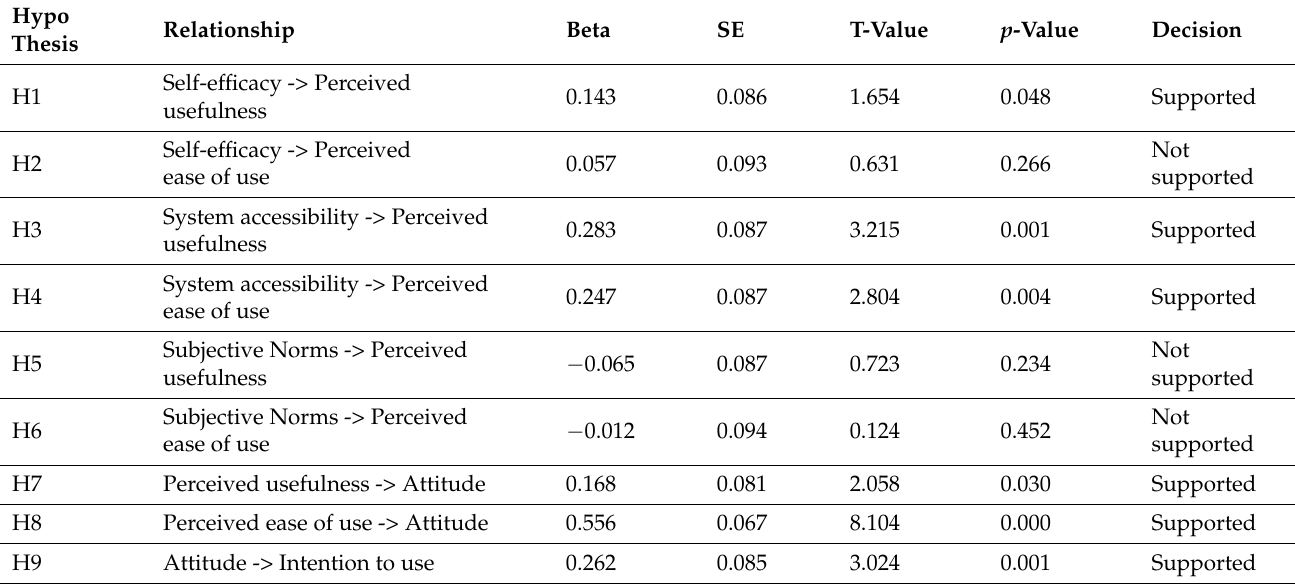
Table 4. Structural Model